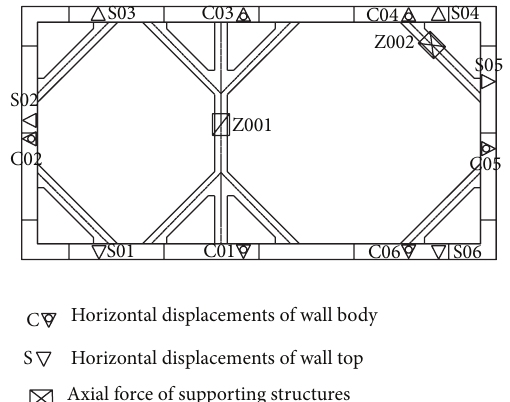
Figure 7: The distribution of monitoring points for the field measurements of displacements of the wall body and wall top as well as the internal force of the supporting